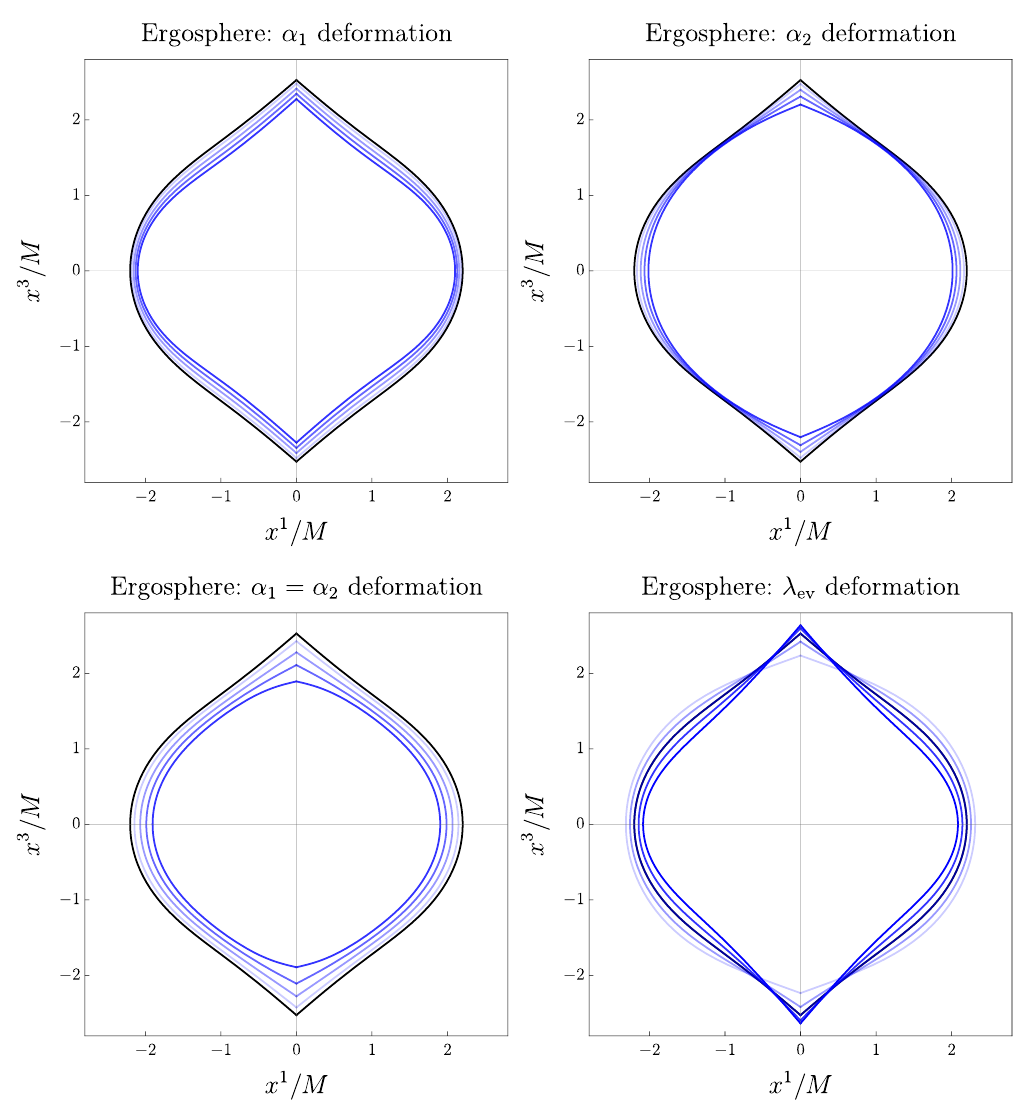
Figure 6 . Isometric embedding of the ergosphere in E 3 for di(cid:11)erent values of the parameters and for (cid:31) = 0 : 65. In black we represent the ergosphere of Kerr black hole and in blue the ergosphere of the corrected solution, for a (cid:12)xed mass and di(cid:11)erent values of the couplings. From light to darker blue we increase the value of the corresponding coupling. In each case, only the indicated couplings are non-vanishing. From left to right and top to bottom: ‘ 4 (cid:11) 2 = 0 : 03 ; 0 : 07 ; 0 : 11 ; 0 : 15, 1 M 4 ‘ 4 (cid:11) 2 = 0 : 03 ; 0 : 07 ; 0 : 11 ; 0 : 15, ‘ 4 (cid:11) 2 = ‘ 4 (cid:11) 2 = 0 : 03 ; 0 : 07 ; 0 : 11 ; 0 : 15, ‘ 4 (cid:21) ev = (cid:0) 0 : 6 ; (cid:0) 0 : 3 ; 0 : 3 ; 0 : 2 1 2 M 4 M 4 M 4 M 4